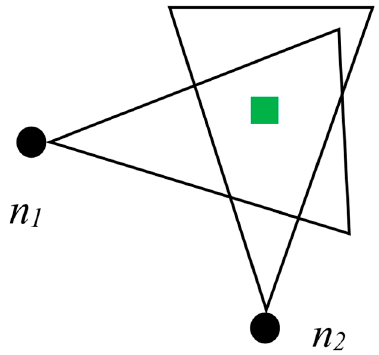
Figure 13. A scenario where two nodes have a distance that is less than two times of the congruent sides of the triangles created due to FoV.